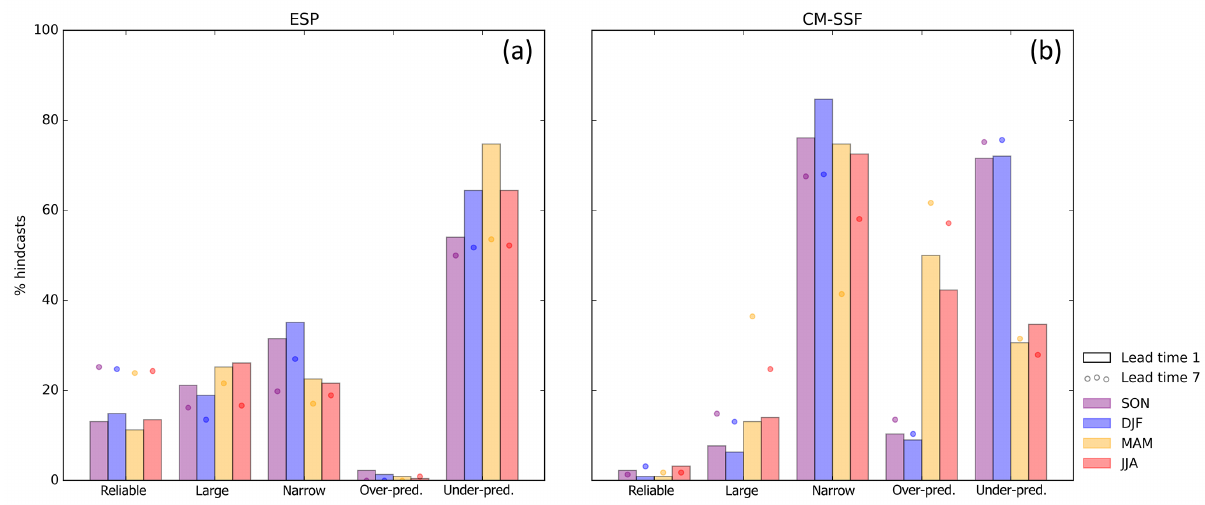
Figure 4. Plots of the percentage of the ESP (a) and the CM-SSF (b) hindcasts falling into each reliability category (reliable – in terms of both spread and bias, too large, too narrow, over-predicting and under-predicting) for all four seasons (SON, DJF, MAM and JJA from the left-most to right-most bars in each reliability category). The results are shown as bar charts for the first month of lead time and as circles for the seventh month of lead time. These lead times were selected for display to highlight the evolution of reliability between the first and last months of the hindcast. The percentages were calculated from hindcasts for all target months falling in a given season and all 74 European regions.